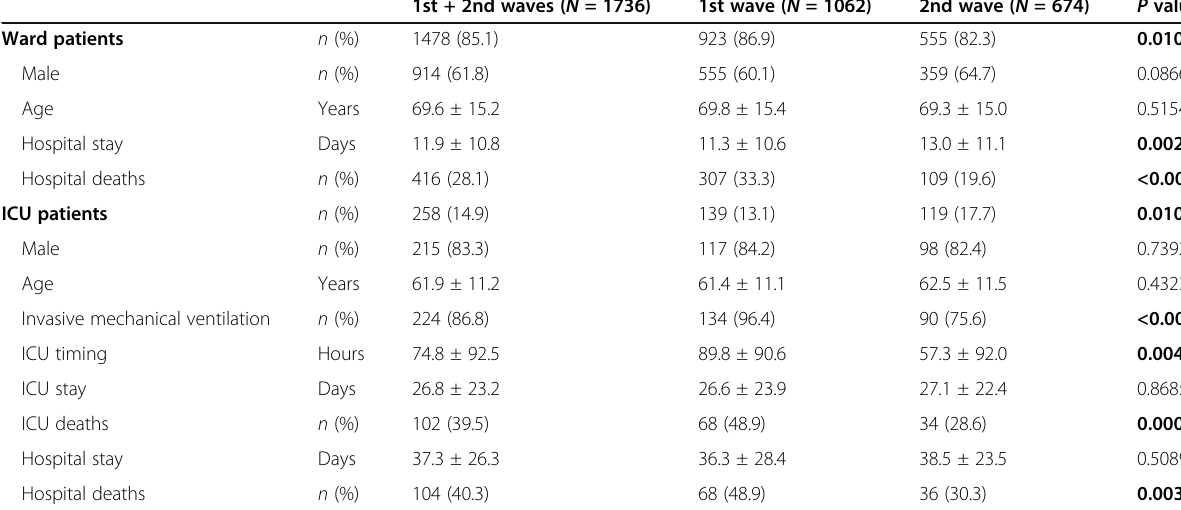
Table 1 Features of the patients admitted to general ward and to ICU during the first and the second COVID-19 waves in Pavia